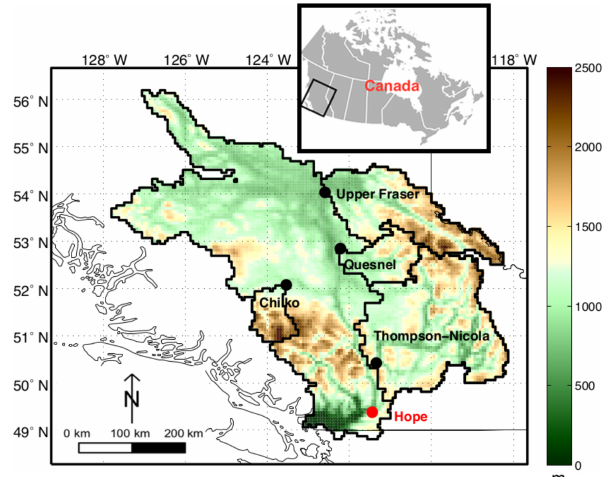
Figure 1. The Fraser River Basin of British Columbia, Canada, and four of its subbasins examined in this study. Colours correspond to elevations as used by the VIC model, at 1 / 16 ◦ horizontal resolution. Locations of streamflow gauge stations at the outlet to each subbasin are shown with black dots, while the major outlet for the FRB at Hope is shown with a red dot. Details of each subbasin are provided in Table